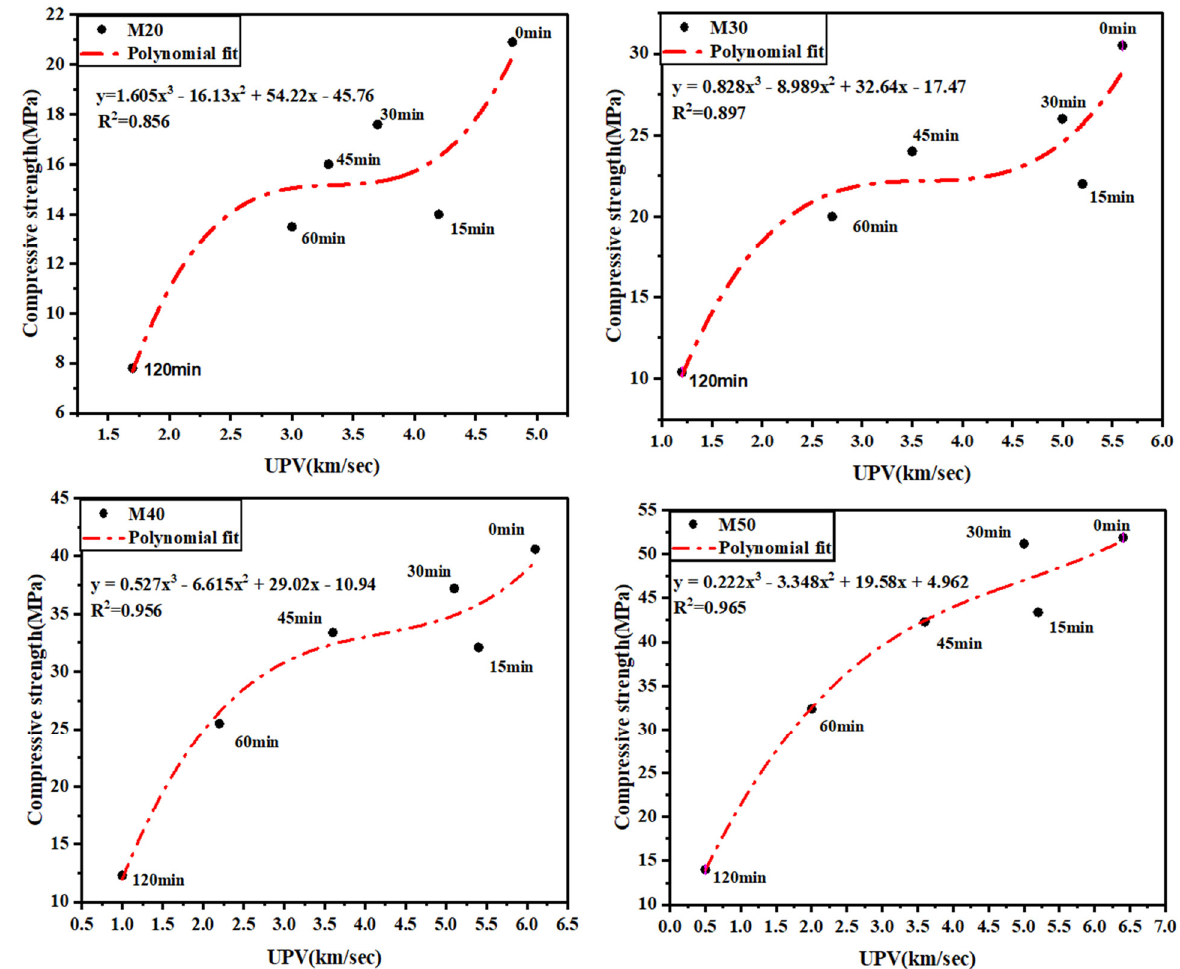
Figure 6. Correlation between compressive strength and UPV of M-20, M-30, M-40, and M-50 con- crete samples.